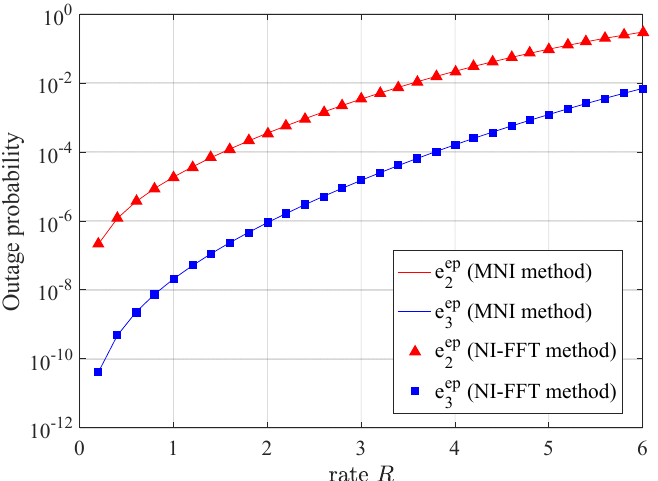
Figure 5. The comparison of the outage probability between the NI-FFT method and the MNI method ( P = 10, K = 5 )